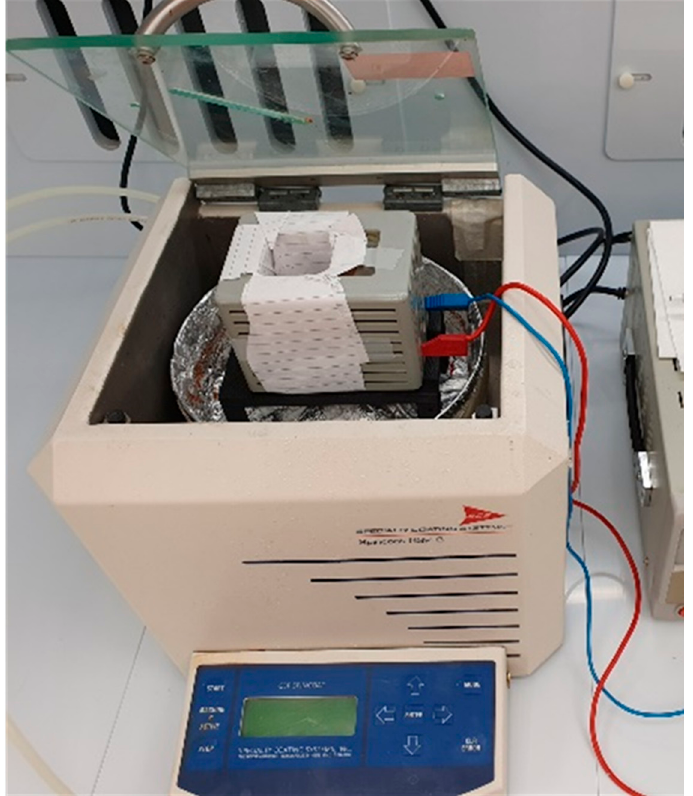
Figure 3. Spin coating configuration for sample rotation under perpendicular magnetic field. We utilize a current source and a coil, which is placed inside the spin coating with a special 3-dimensional—printed base, replacing the Spin Coaters’s sample holder.